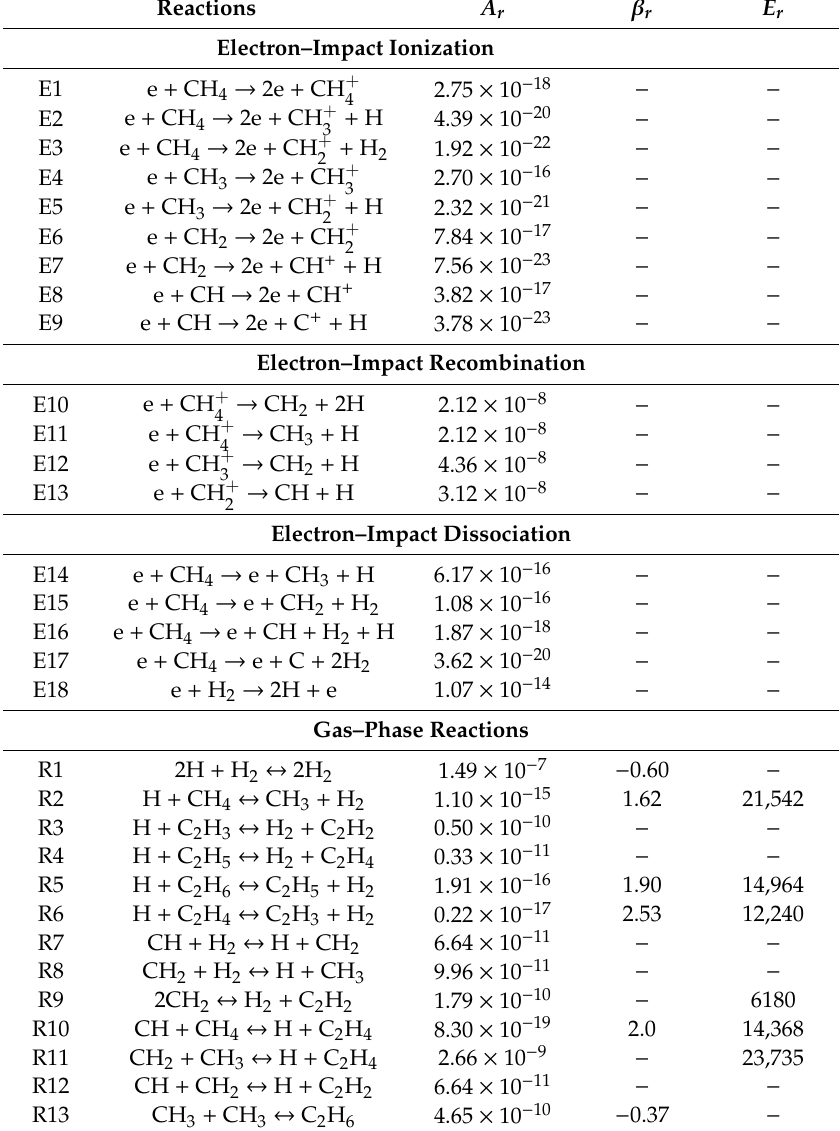
Table 3. Overall reactions scheme. Electron-impact reaction rates were calculated at T elec = 1.7 eV. Reaction rate coe ffi cients k r = A r T β r exp ( − E r / T ) . Units: A r , cm · molecules · s · K; β r , dimensionless; E r = E a / R ,